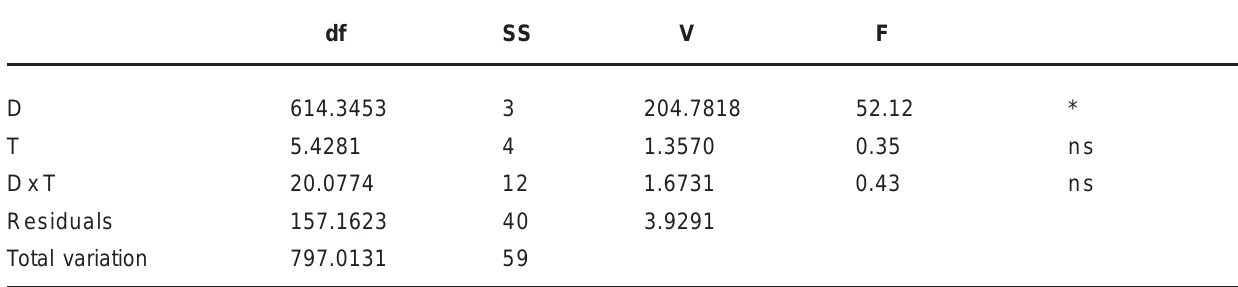
TABLE 3- ANOVA table for weight loss of artificial teeth df SS